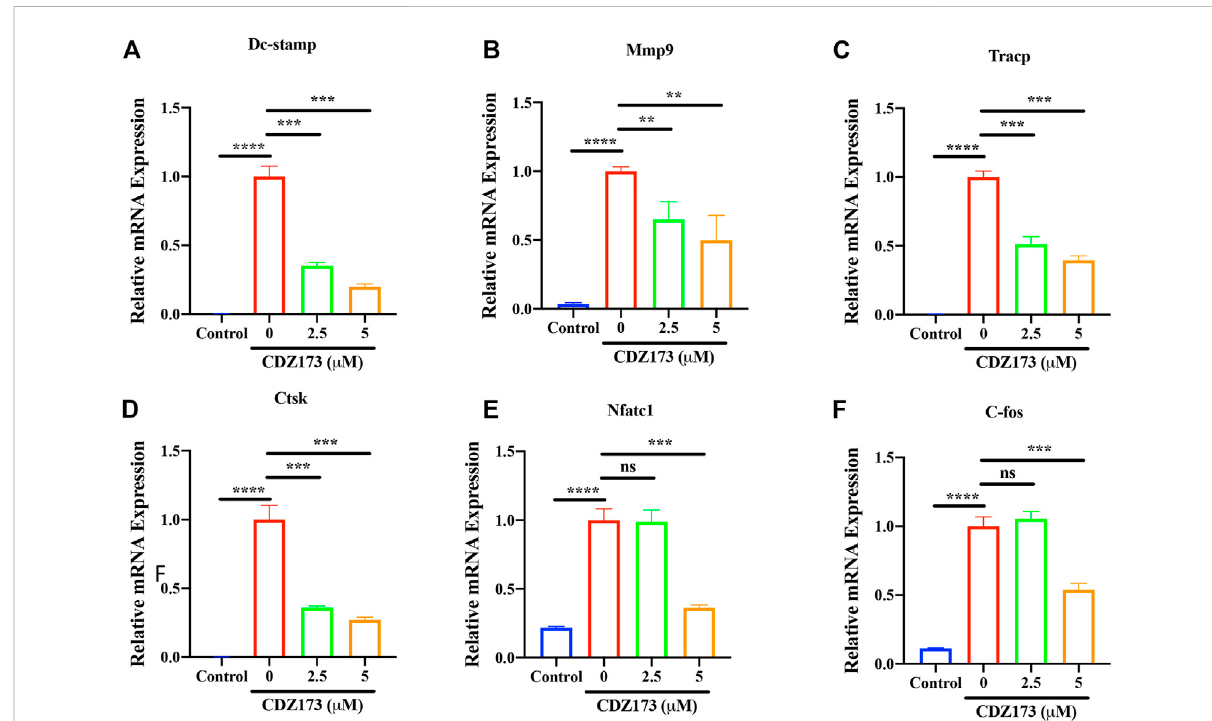
FIGURE 5 CDZ173 suppressed RANKL-induced expressionofOC-Speci fi cgenes. BMMswerestimulated withM-CSF(30 ng/ml), and RANKL (30 ng/ml)in theabsence orpresenceof indicated concentrationsof CDZ173 for 5 days to form multinucleated TRAP positive OCs. Speci fi cprimers were